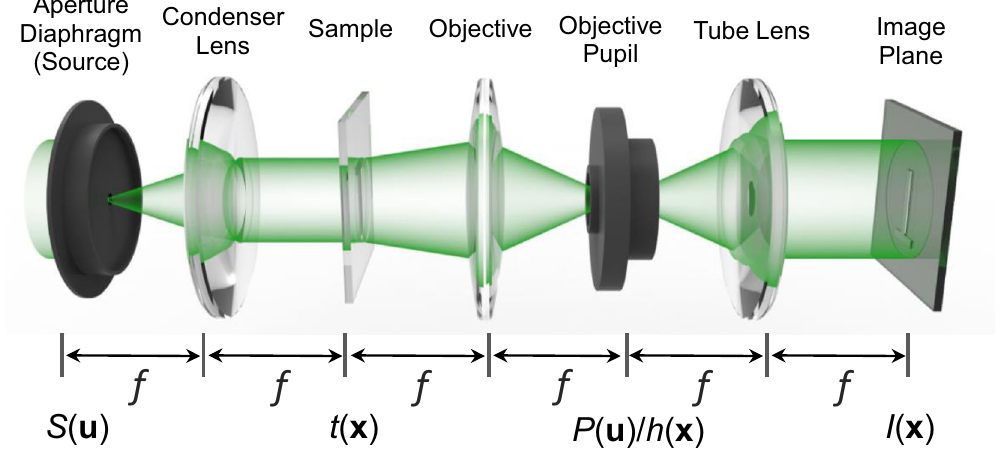
Figure 1. Description of image formation in a partially coherent